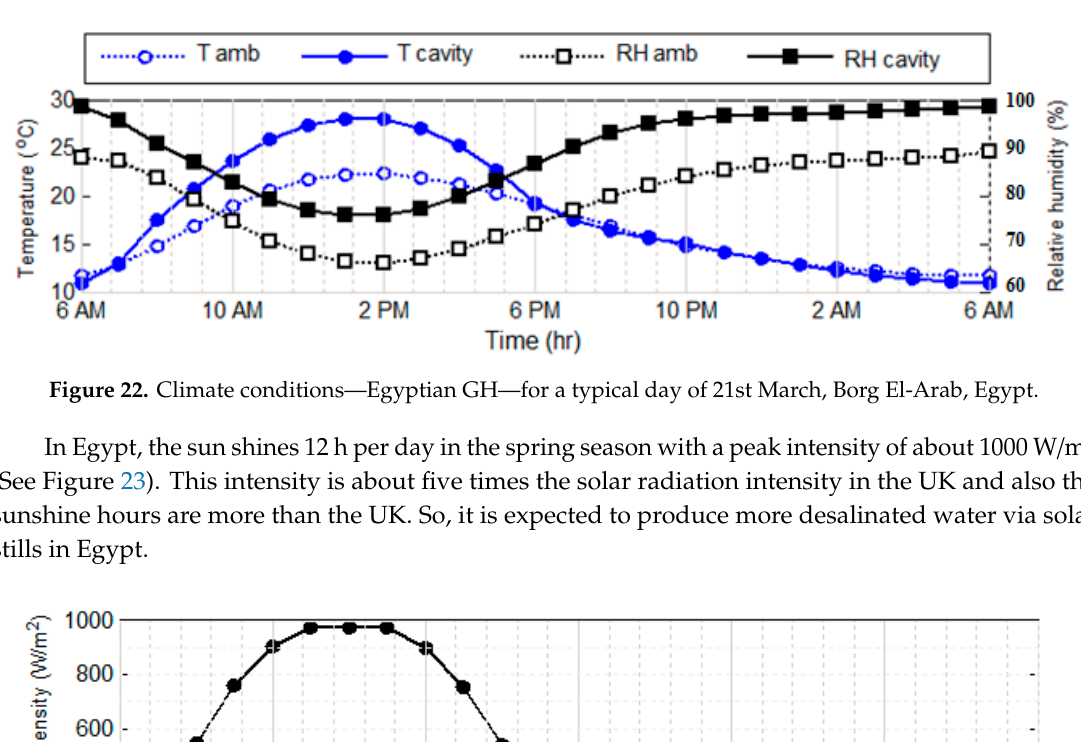
Figure 21. Egypt GH structure [61].